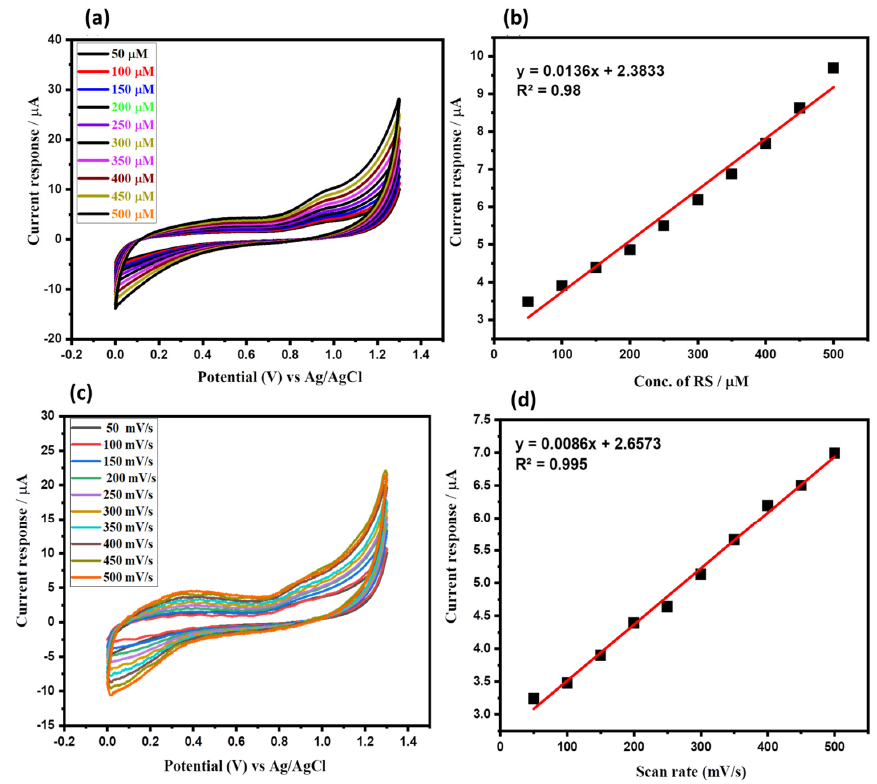
Figure 4. ( a ) CV responses and calibration plot ( b ) of the MGC for 50–500 µM RS at a scan rate of 50 mV/s. ( c ) CV responses and calibration plot ( d ) of the MGC for 50 µM RS at a scan rate of 50–500 mV/s.